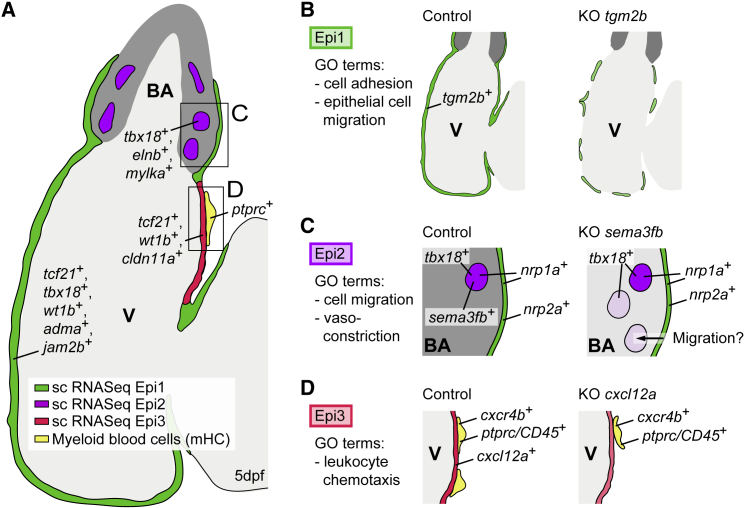
Summary of the Distinct Epicardial Cell Populations in the Developing Zebrafish Heart(A) Zebrafish heart at 5 dpf, showing the distributions of Epi1-3.(B) Loss of tgm2b disrupts the integrity of the epicardial cell layer.(C) Loss of sema3fb increases the number of Epi2 cells in the BA, possibly owing to increased cell migration from the epicardium.(D) Loss of cxcl12a decreases the number of myeloid cells on the heart. V, ventricle; BA, bulbus arteriosus.